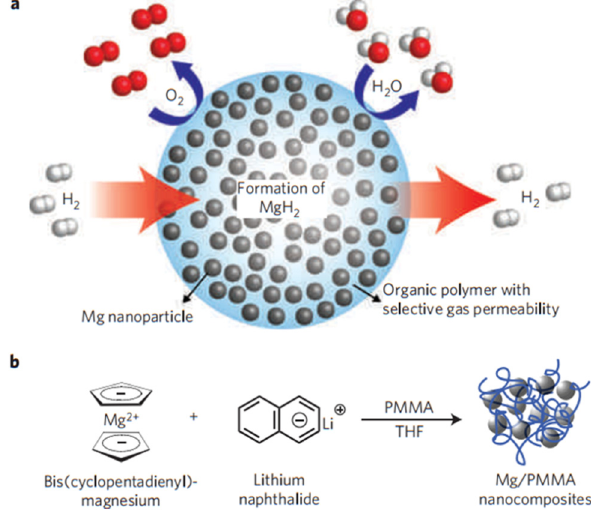
Figure 8: Mg nanocomposites in a gas - barrier polymer matrix. a ) Schematic of hydrogen storage composite material: high - capa - city Mg nanocomposites are encapsulated by a selectively gas - permeable polymer. b ) Synthetic approach to formation of the Mg nanocomposites [ 201 ]